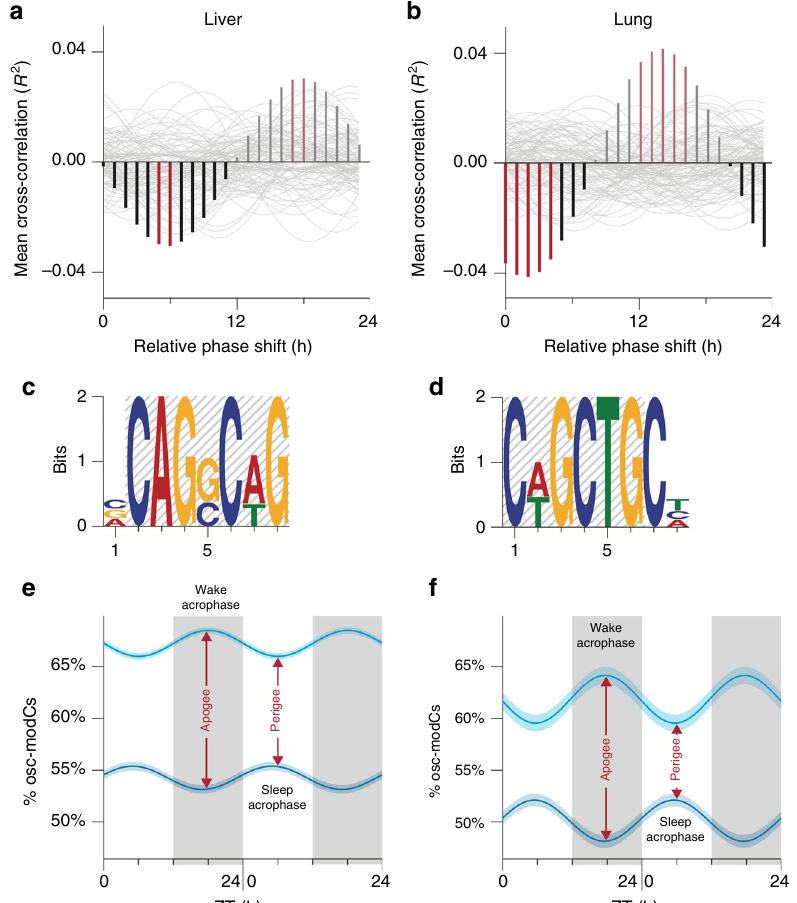
Fig. 5 The transcriptional and temporal coordination of oscillating modi fi ed cytosines in the 9-mo mouse liver and lung. a , b Mean gene-body modi fi cation densities of epigenetically variable cytosines in a the liver and b the lung were cross-correlated with corresponding circadian mRNA pro fi les after each iteration of a forward 1 h phase shift in the mRNA pro fi les. Bars represent the observed mean cross-correlation between mRNAs and modi fi cation densities for a given phase shift (red bars indicate Bonferroni corrected permuted p < 0.05). The positive faded bars are mirror images of the negative bars (by nature of correlating phase shifted waves, a wave shifted by half a period anti-correlates with itself). Fine gray curves in the background depict cross- correlations of 100 randomly selected (out of 10,000) permutations where both ZT labels and mRNA-gene modi fi cation density pairs were shuf fl ed. c , d Representative E-box motifs enriched within 100 bp in either direction of osc-modCs in c the mouse liver and d the lung. e , f Harmonic regression fi ts on the average modi fi cation density of osc-modCs with wake and sleep acrophases in e the mouse liver and f the lung, as a function of ZT. Shading around the regression lines represents the 95% con fi dence band. ZT, Zeitgeber time; modC, cytosine modi fi